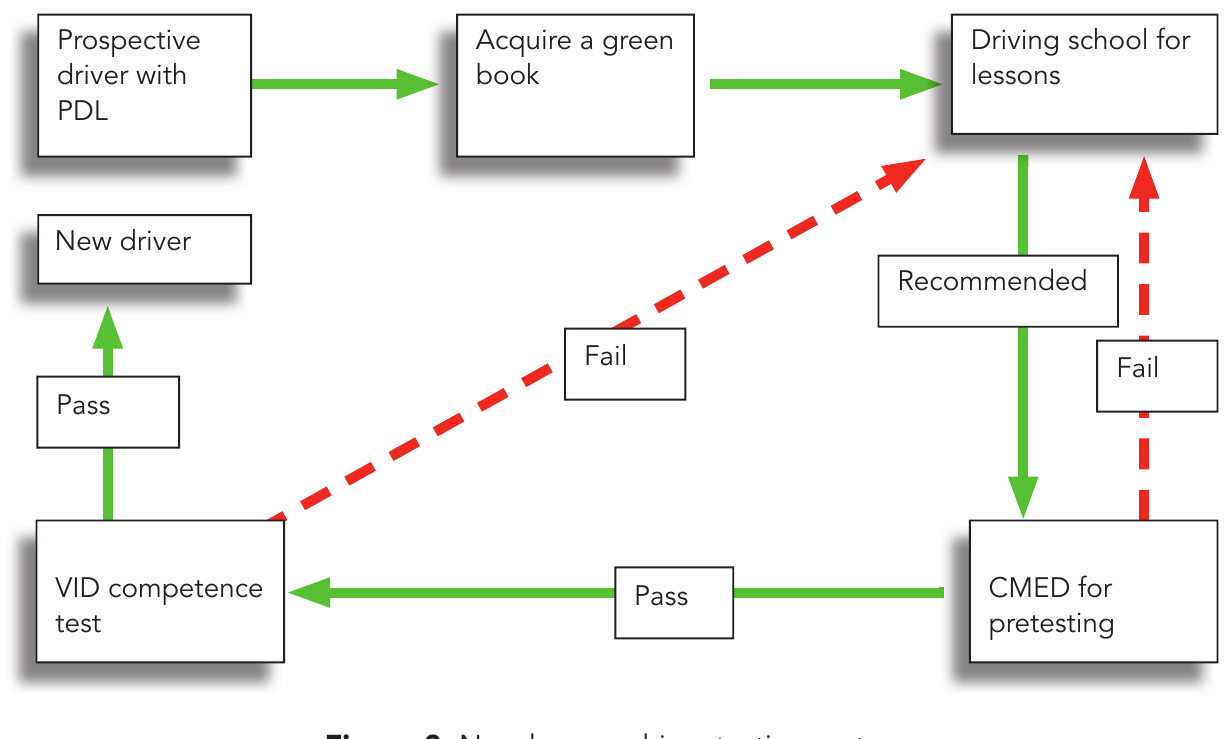
Figure 2: New learner driver testing